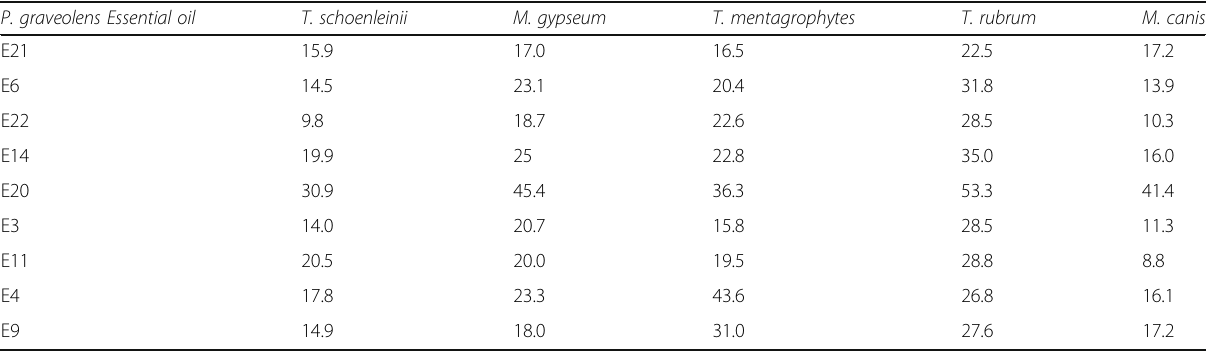
Table 2 Mycelium growth inhibition of dermatophytes by 200 ppm P. graveolens essential